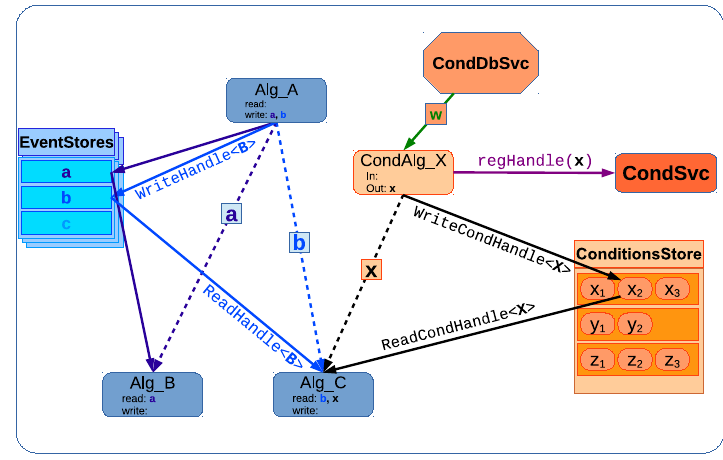
Figure 2. Accessing ConditionHandles in